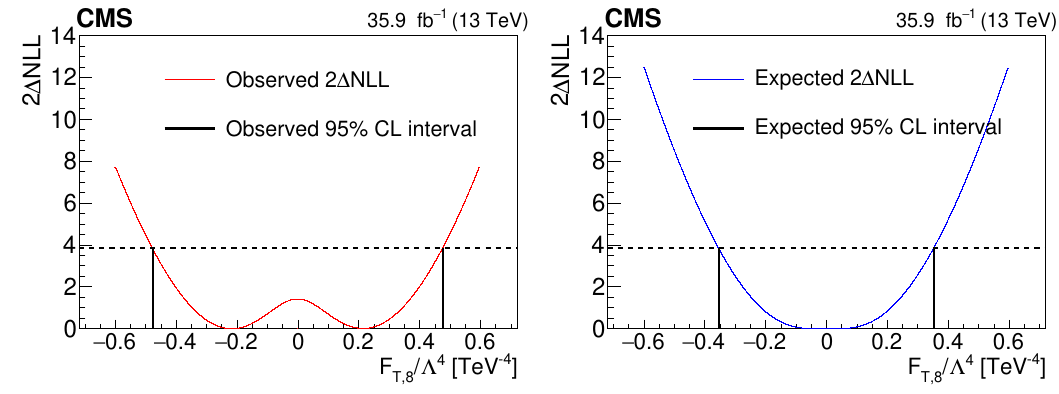
Figure 7 . Observed (left) and expected (right) 95% CL intervals on the aQGC parameter F